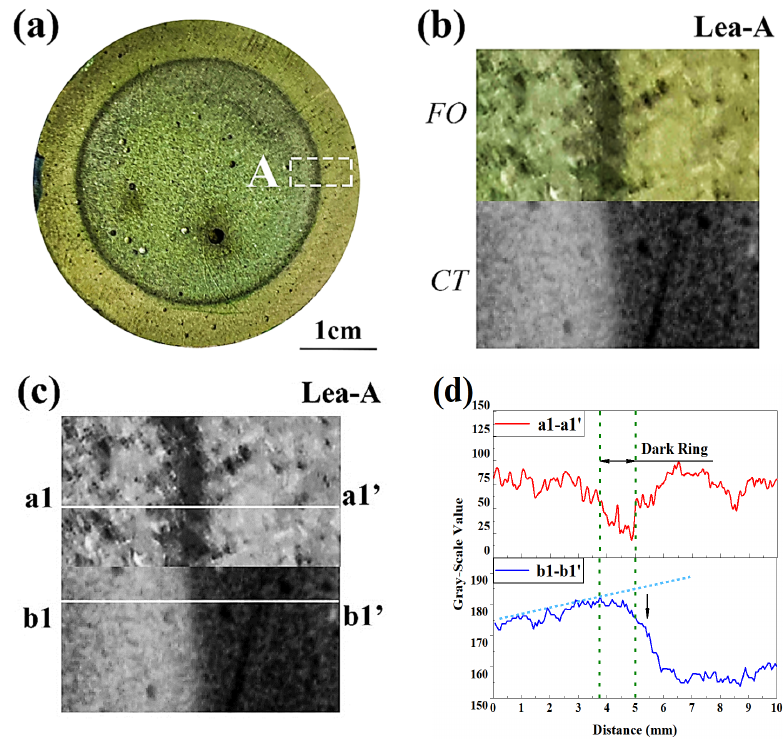
Figure 9. Partly leached specimen. ( a ) Cross-section sprayed with F. orchid indicator; ( b ) magnified local image of A and related CT image; ( c ) binarized image of ( b ); ( d ) 1D distribution of grayscale value along a1-a1 ′ and b1-b1 ′ in ( c ).